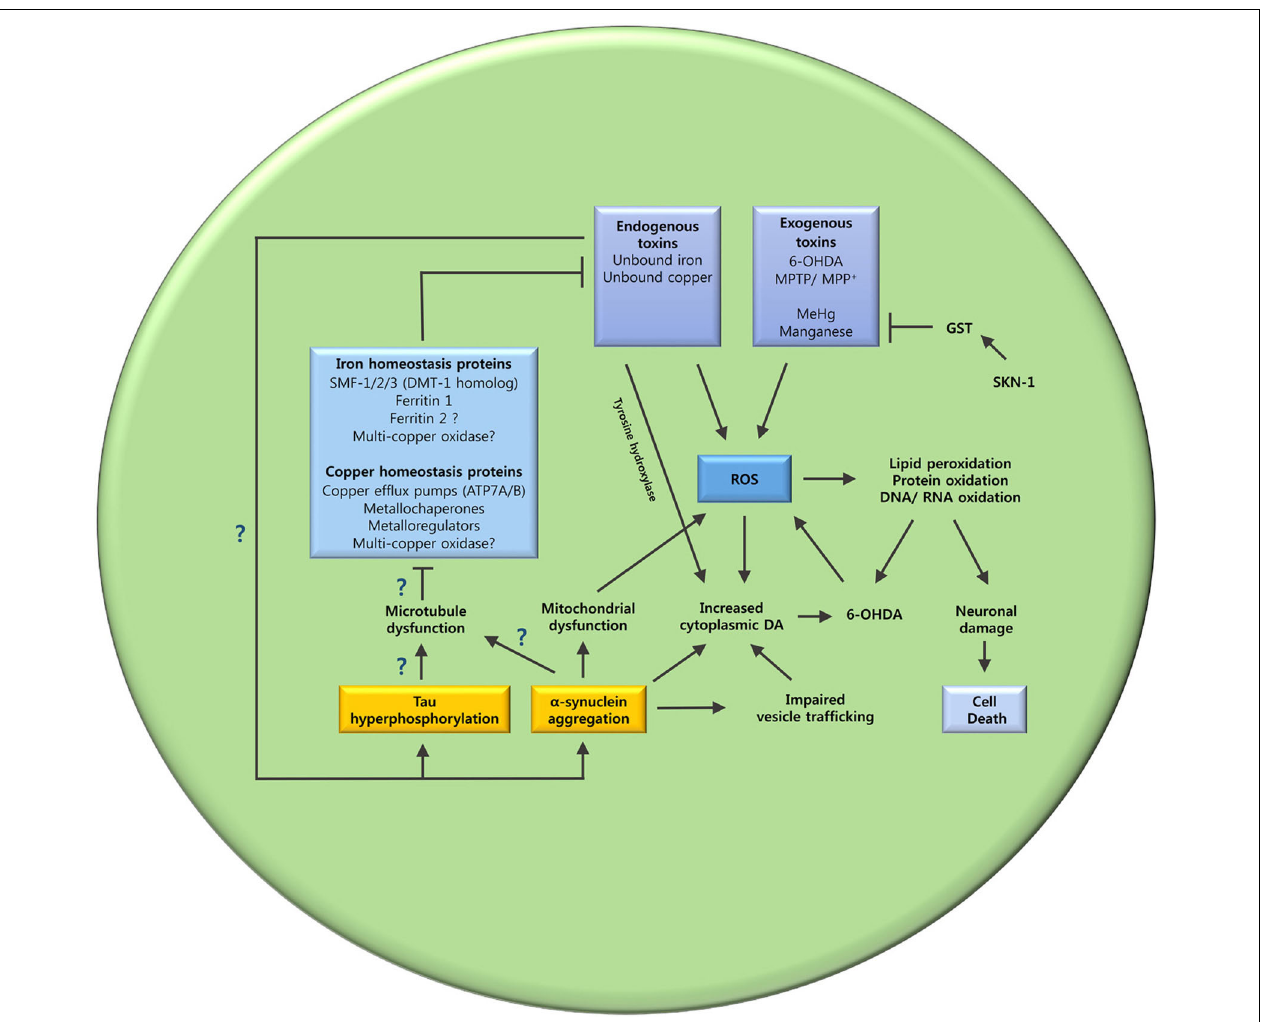
FIGURE 3 | The oxidative stress and metal ion dyshomeostasis cascade. This schematic summarizes the hypothesized mechanisms that may lead to oxidative stress and metal dyshomeostasis in DAergic neurons of C. elegans PD models. The unanswered questions are also highlighted. Does tau hyperphosphorylation and α -synuclein